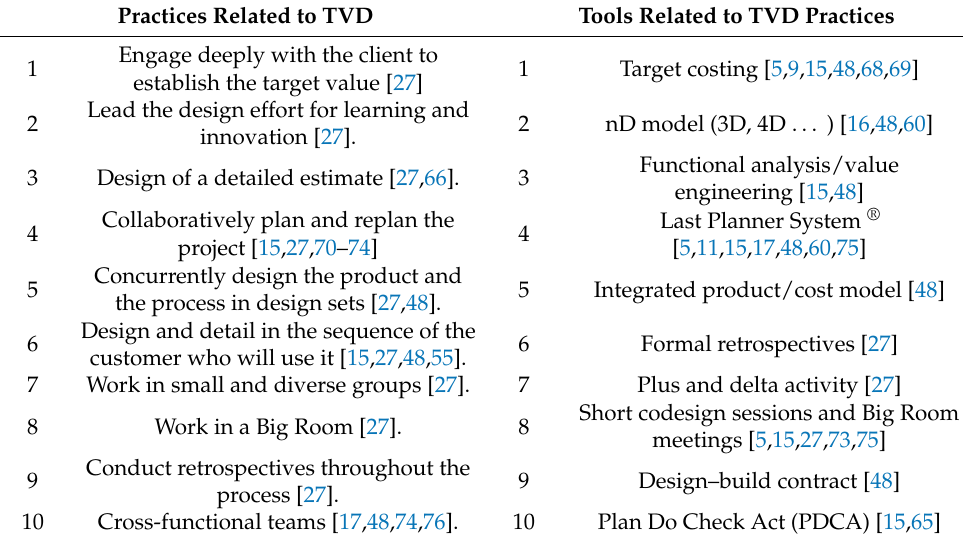
Table 1. TVD practices, updates, and related